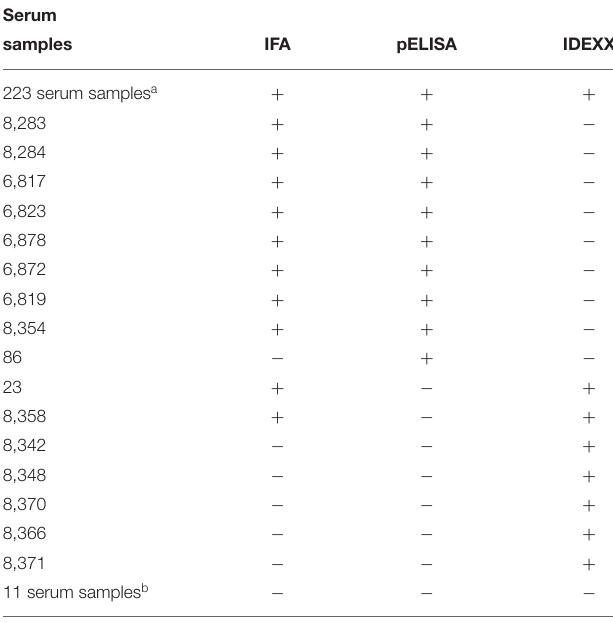
TABLE 2 | Comparison of the pELISA, IFA, and the commercial IBV ELISA kit for 250 field serum samples. Serum